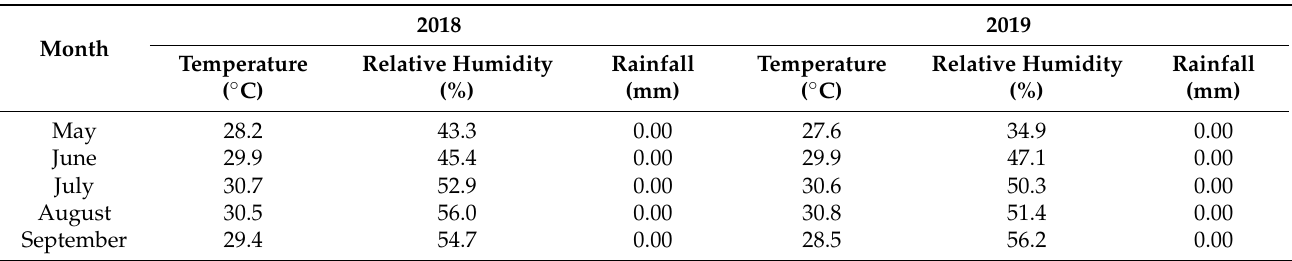
Table 1. Average temperature, relative humidity and rainfall in the study area in Giza, Egypt, during the two growing seasons of 2018 and 2019 *.